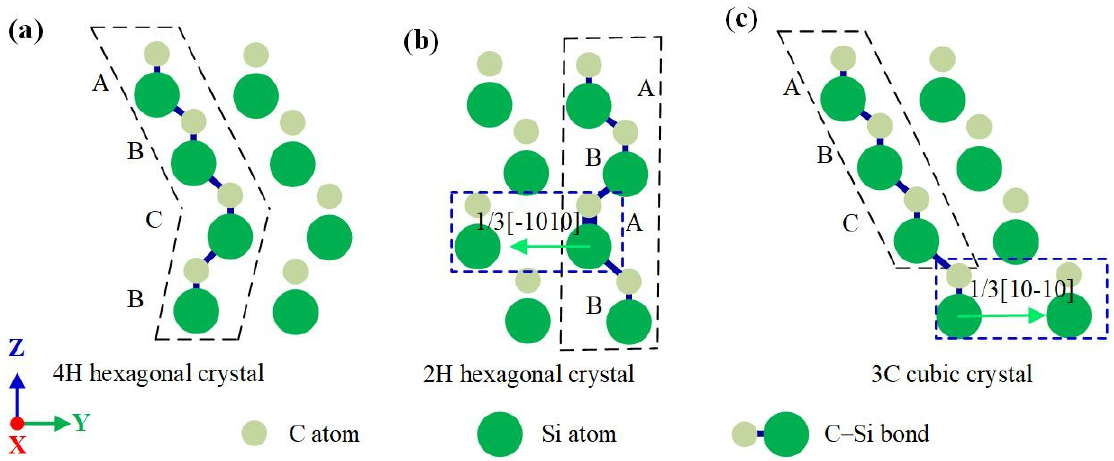
Figure 11. Schematic diagram of the stacking faults formation in 4H-SiC. ( a ) 4h hexagonal crystal structure, ( b ) 2H hexagonal crystal, and ( c ) 3C cubic crystal.